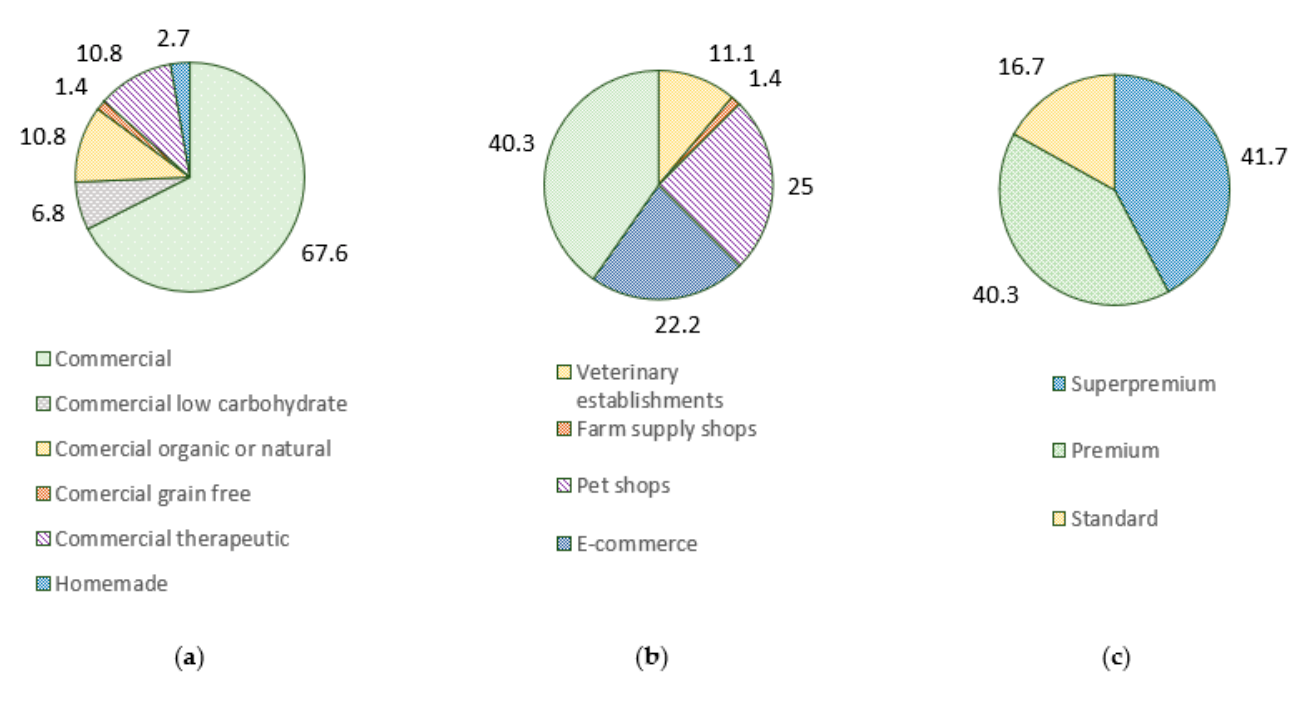
Figure 1. Percentage (%) of reported diet choices regarding type of diet ( a ), place of purchase ( b ), and diet quality ( c ) used by Portuguese owners responding the survey.